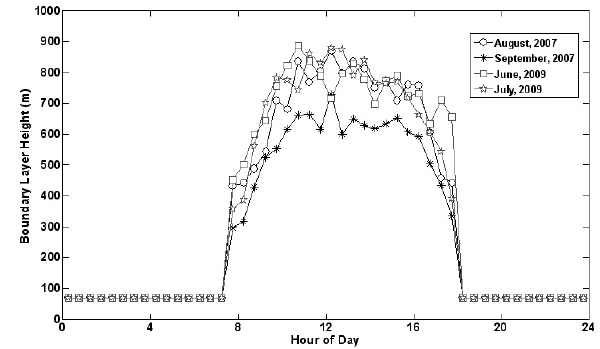
Figure 8. Monthly mean diurnal patterns of estimated ABL heights during the BEARPEX 2007 and 2009 campaigns. The NBL height is the mean value (67m) obtained from radiosonde measurements conducted during BEARPEX 2009. White circles and asterisks represent the monthly mean estimate of z i for August and September in 2007, respectively, and white squares and stars for June and July in 2009.